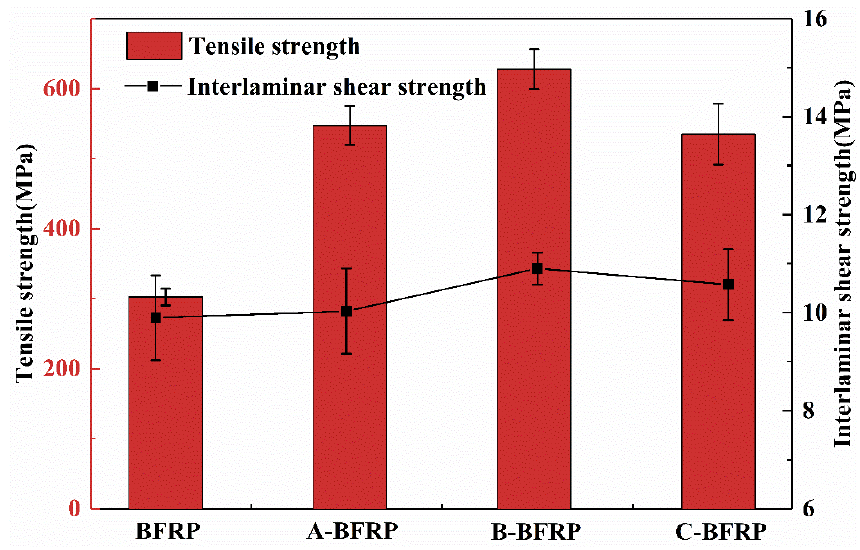
Figure 3. Tensile and interlaminar shear properties of basalt fiber/epoxy resin composites.